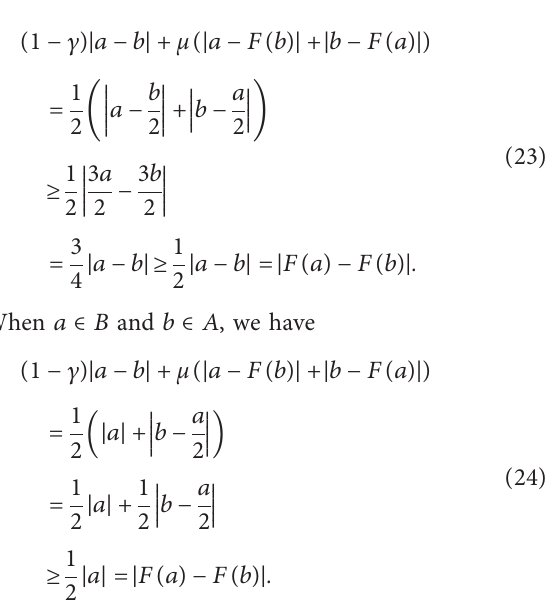
Figure 1: Convergence behavior of Picard–Krasnoselskii, Picard, and Krasnoselskii iterates for mapping F defined in Example 1 � 0 . where a 1